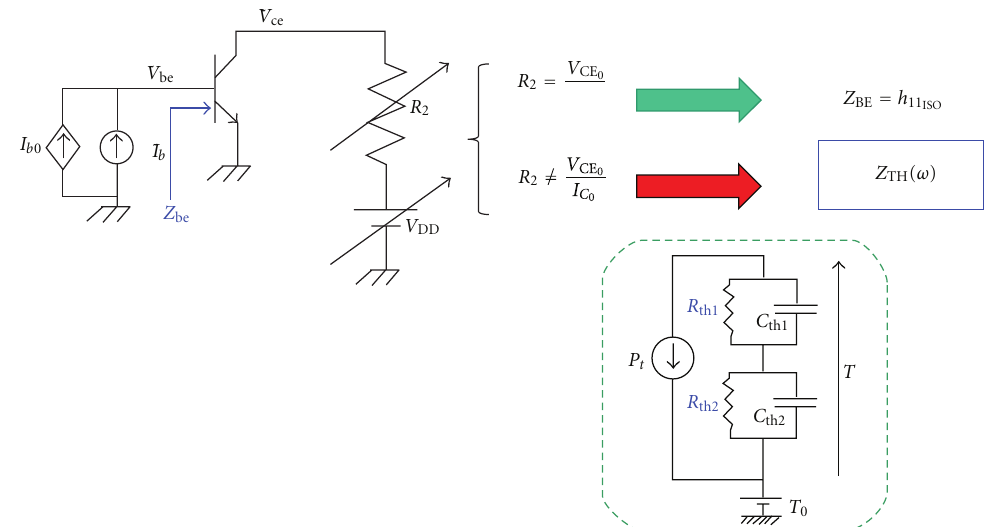
Figure 3: Determination of thermal impedance.